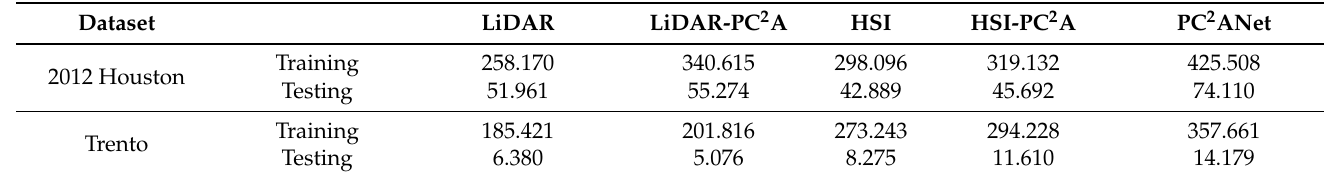
Table 6. Training and testing time (seconds) cost compared to models for single-source classification.